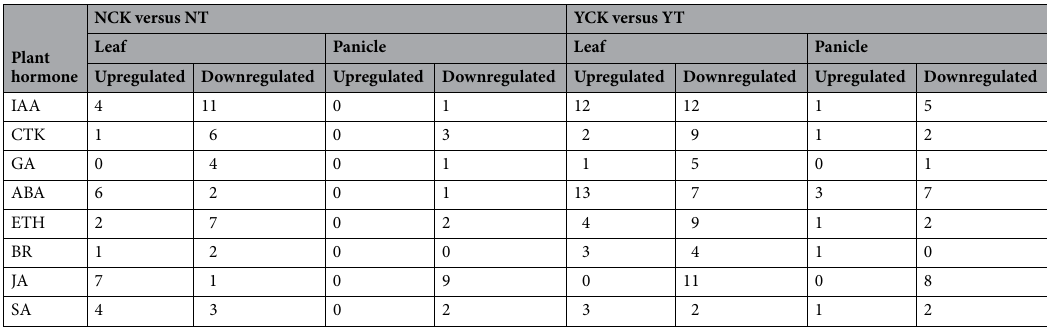
Table 5. DEGs in the plant hormone signal transduction pathway in the leaves and panicles of Ninggeng 4 and Yongyou 538. IAA: Auxin; CTK: Cytokinin; GA: Gibberellin; ABA: Abscisic acid; ETH: Ethylene; BR: Brassinosteroid; JA: Jasmonic acid; SA: Salicylic